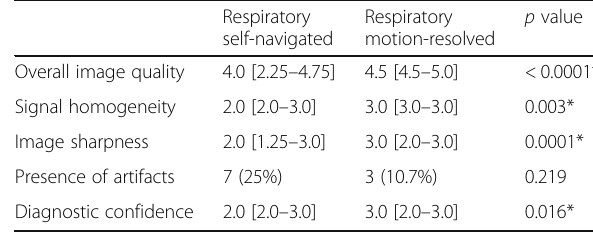
Table 1 Subjective image quality parameters. Data are